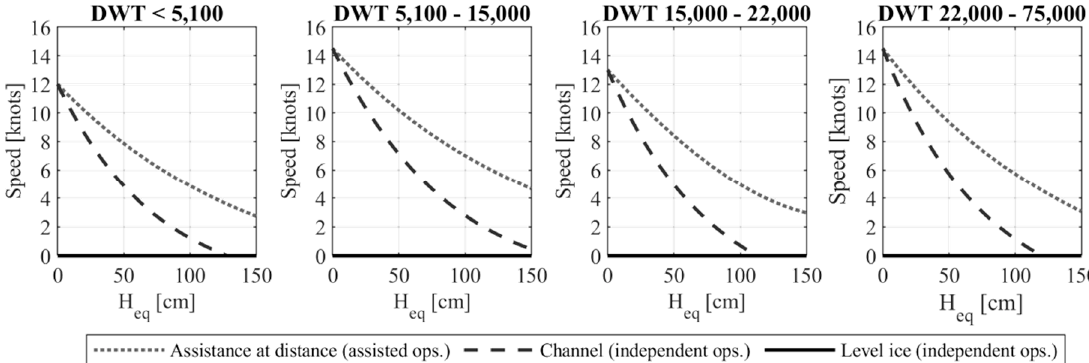
Figure 9. Assumed speed in ice of Energy Efficiency Design Index (EEDI) compliant ships [26].